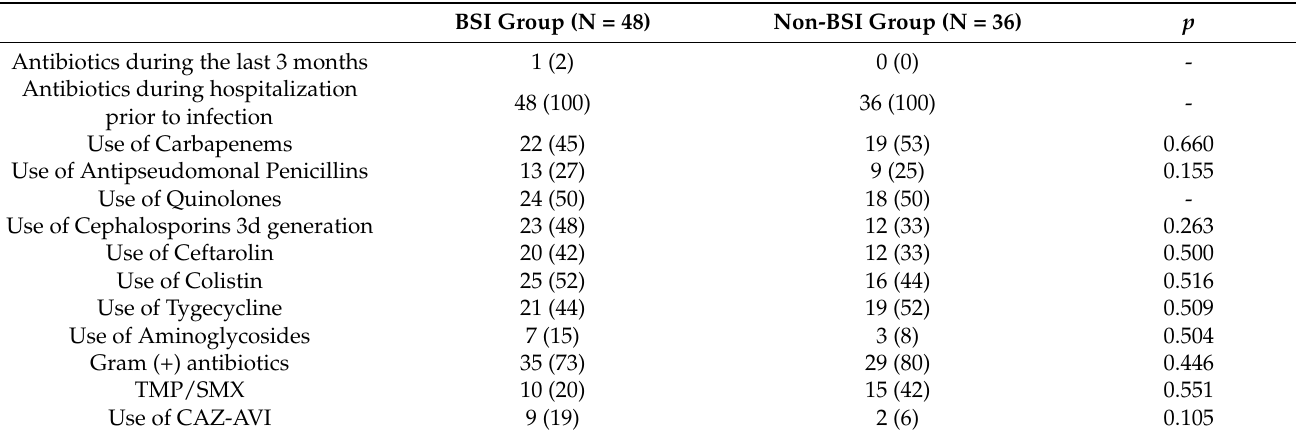
Table 3. Antibiotics administered to participants before BSI.